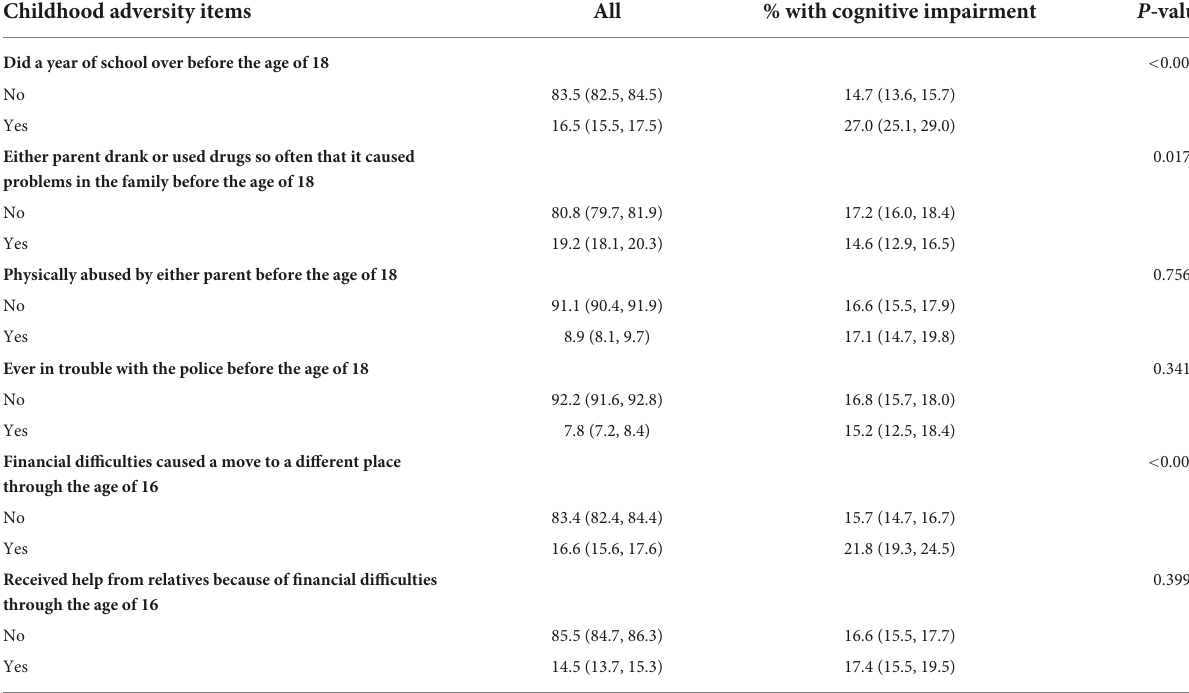
TABLE 2 Prevalence of cognitive impairment in 2010 by the experience of childhood adversity. Childhood adversity